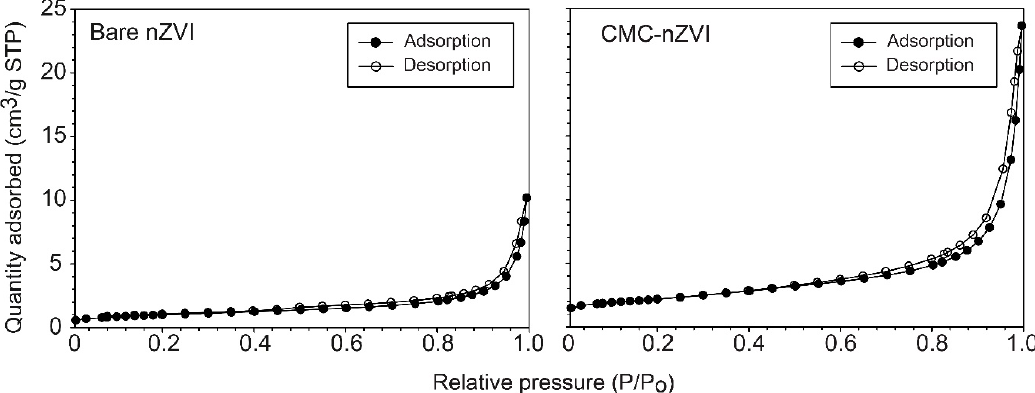
Figure 2. Effect of CMC polymer stabilizer on the Brunauer, Emmett and Teller (BET) adsorption/desorption isotherms of nZVI particles.